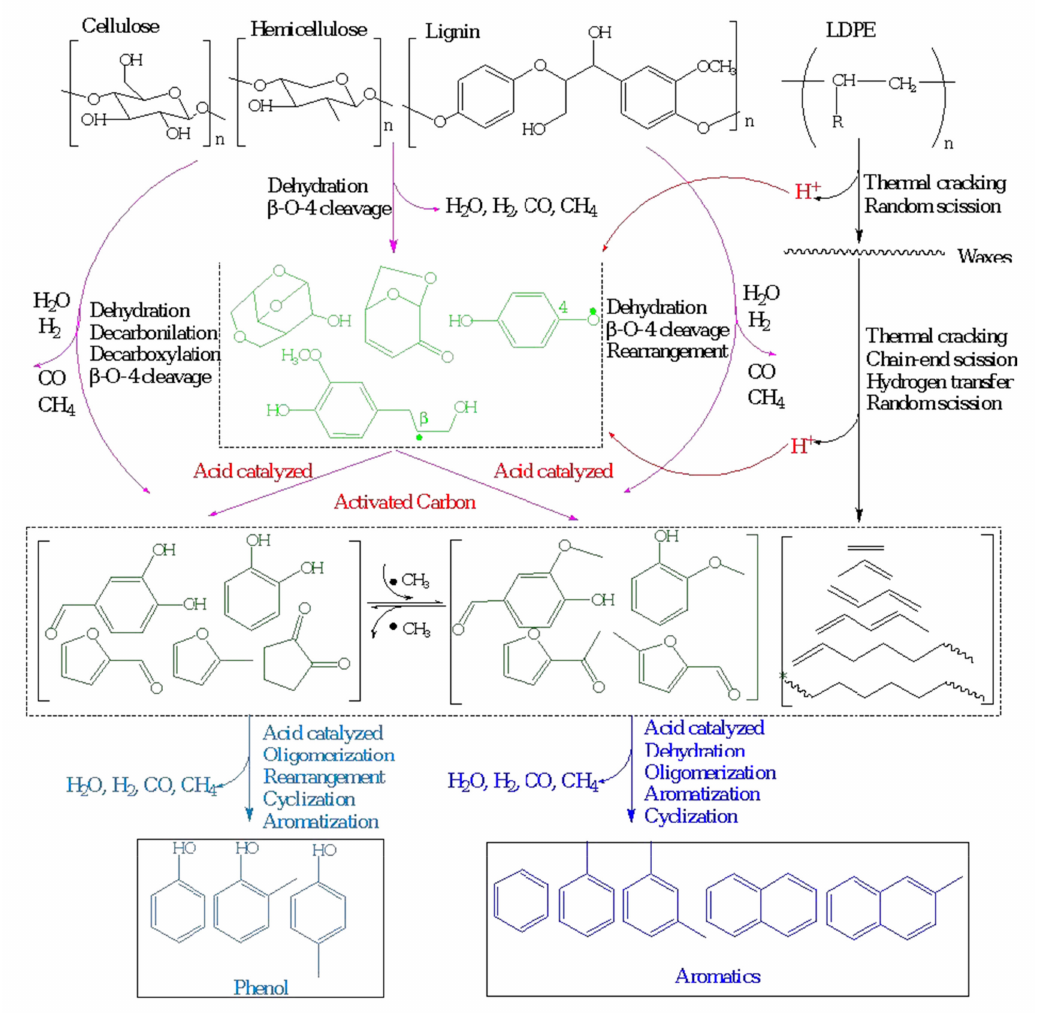
Figure 7. Reaction pathway of AC-catalyzed co-pyrolysis of LB and LDPE to phenols and aromatics